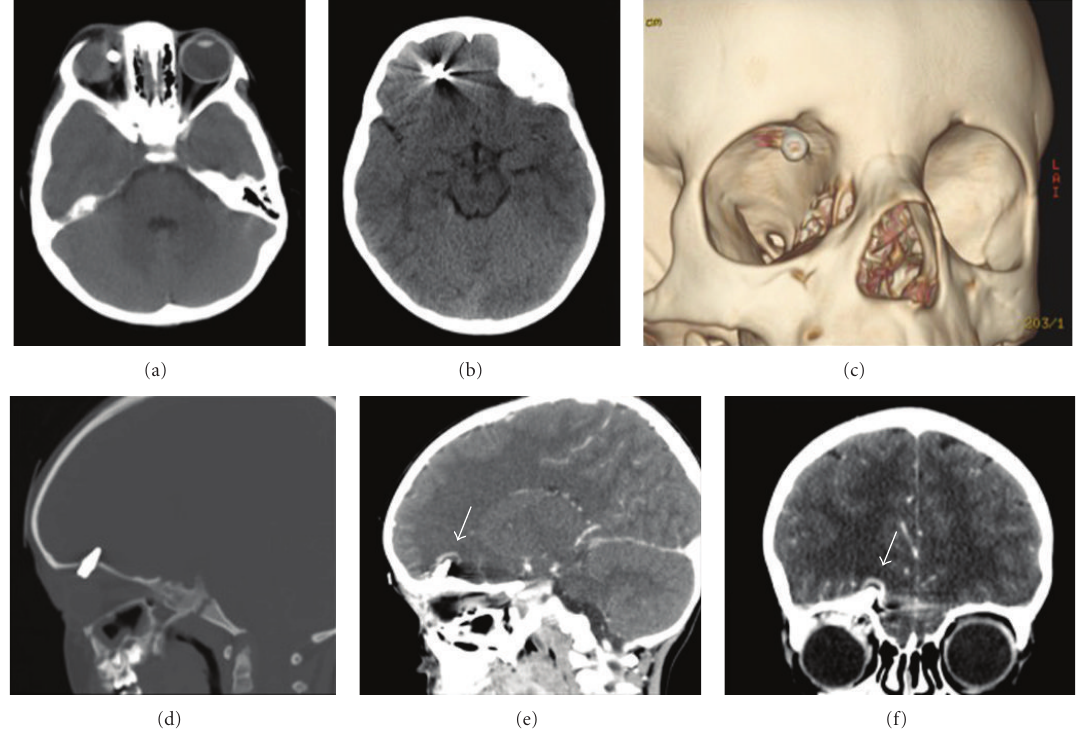
Figure 2: Computed tomography (CT) scans of the brain and orbits depicting the foreign body within the orbit and right frontal lobe (a) and (b). The medial orbital roof foreign body penetration site is shown in 3D CT (c). The foreign body shape (pen’s tip) and the surrounding rim enhancement indicating the presence of abscess is shown in figures (d), (e), and